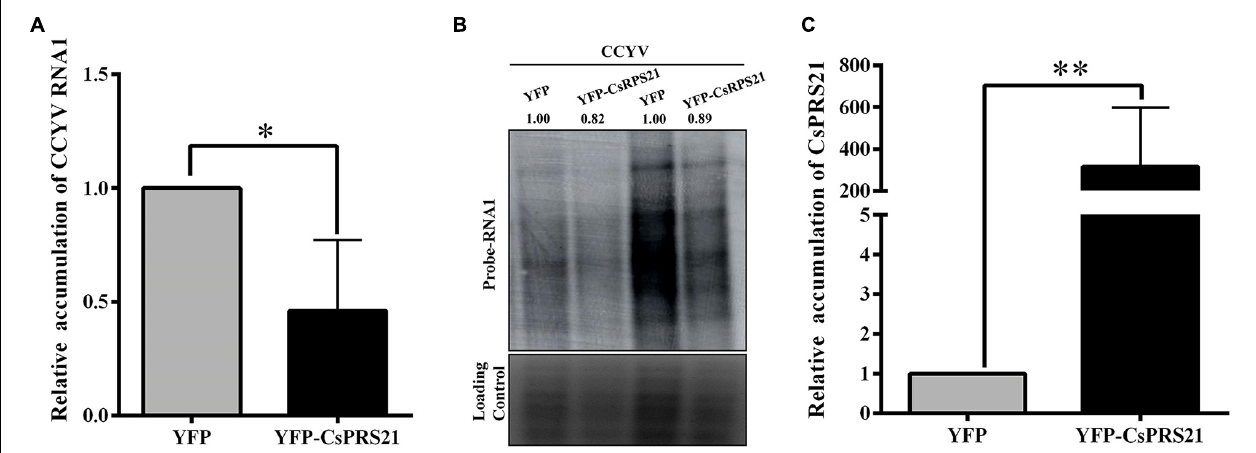
FIGURE 5 | Transient expression of CsRPS21 in N. benthamiana protoplasts inhibited CCYV accumulation. (A,B) Accumulation of CCYV RNA1 of transfected protoplasts was measured using RT-qPCR and northern blotting with the probe of CCYV RNA1 at 24 hpi. (C) Protoplasts isolated from YFP-CsRPS21 and YFP agroinfiltrated N. benthamiana leaves were transfected with CCYV RNA1 and RNA2. Accumulation of CsRPS21 was measured using RT-qPCR at 24 hpi. Data were pooled across experiments and statistically analyzed using t -tests. Bars represents the mean ± standard deviation (SD). Single and double asterisks indicate significant differences at ∗ p < 0.05 and ∗∗ p < 0.01,